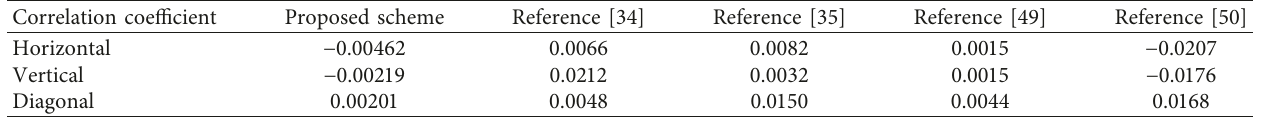
Table 5: Correlation coefficient comparison for encrypted Lena image.